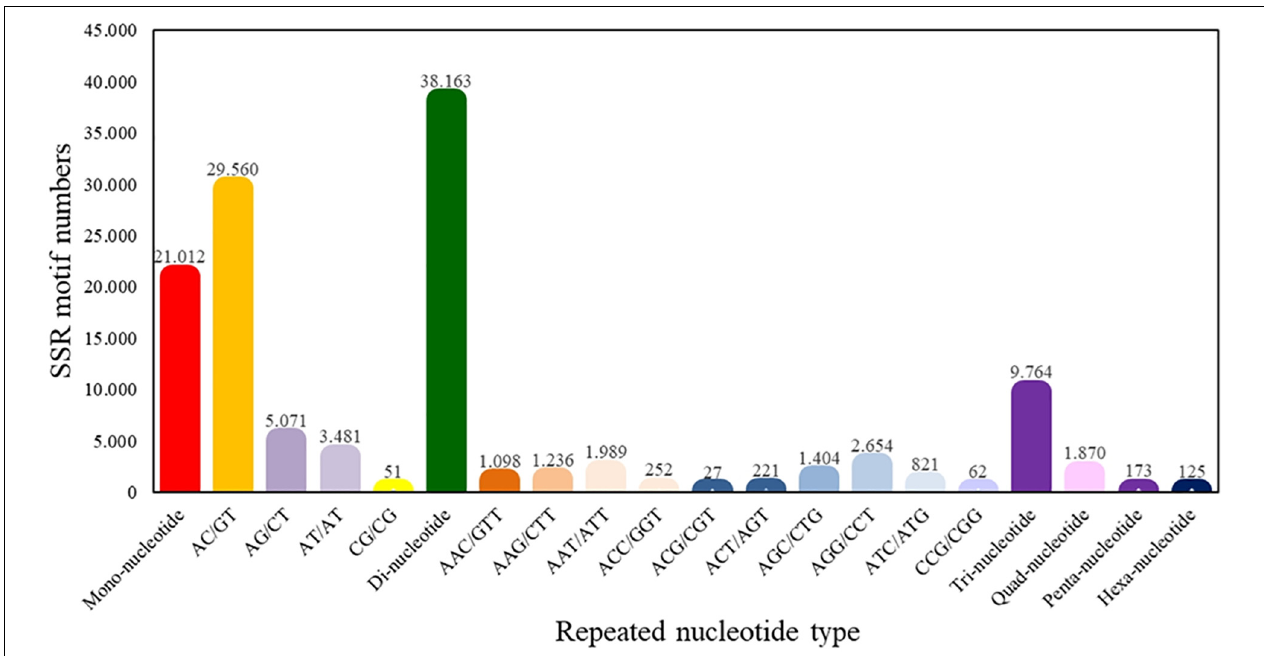
FIGURE 4 | Quantity statistics of EST-SSRs classification. The X -axis is the repeat times of repeat units. The Y -axis is the number of SSR of Patagonian